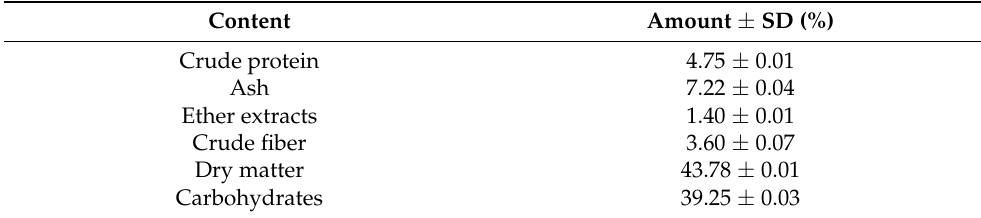
Table 7. Proximate composition of baobab fruit pulp.